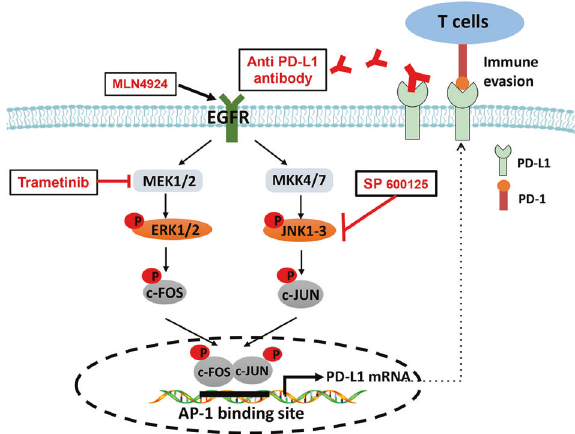
Fig. 7 Working model. MLN4924 activates MEK1/2-ERK1/2 and MKK4/7-JNK kinases to induce c-FOS and c-JUN,